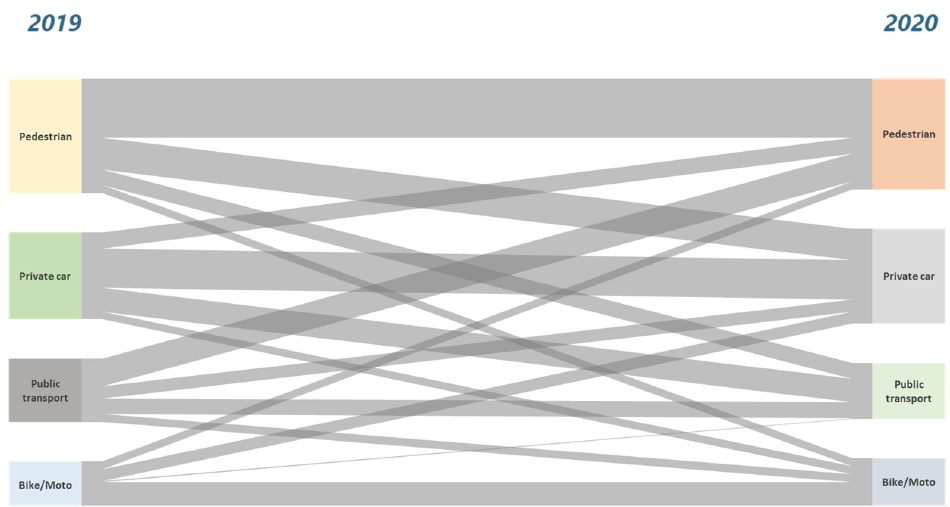
Figure 12. Simplified Sankey diagram of modal distribution transfer between 2019 and 2020 due to the pandemic.